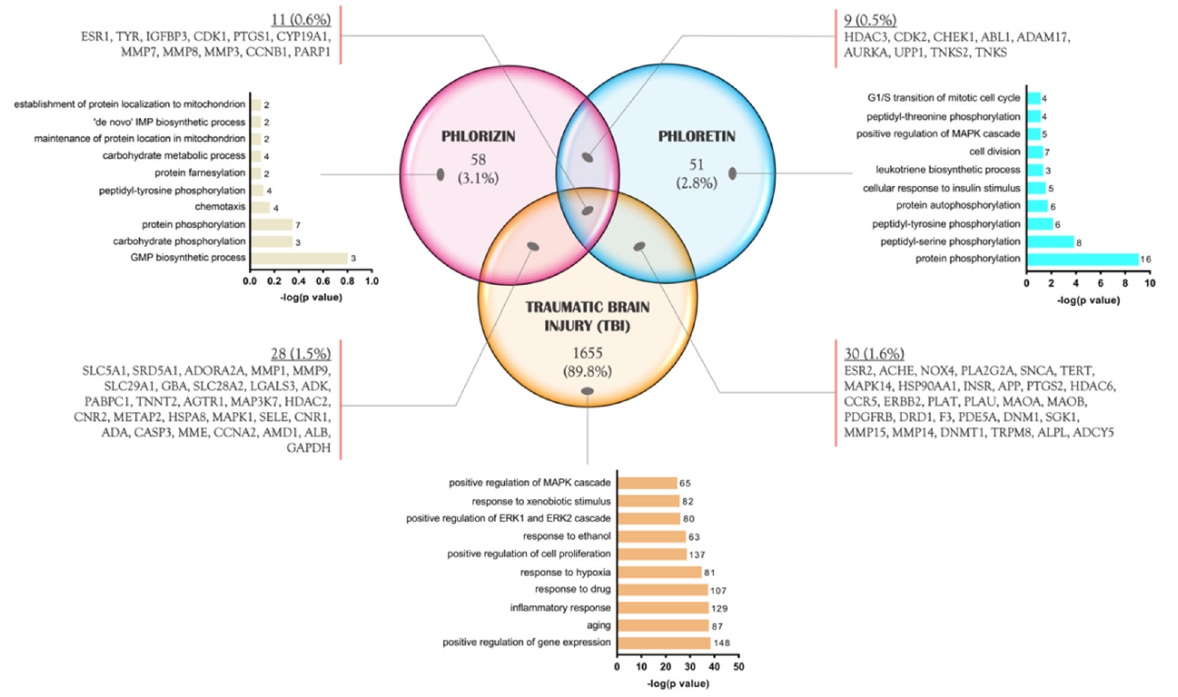
Figure 3. Venn diagram of common proteins between phlorizin, phloretin, and TBI. In the diagram